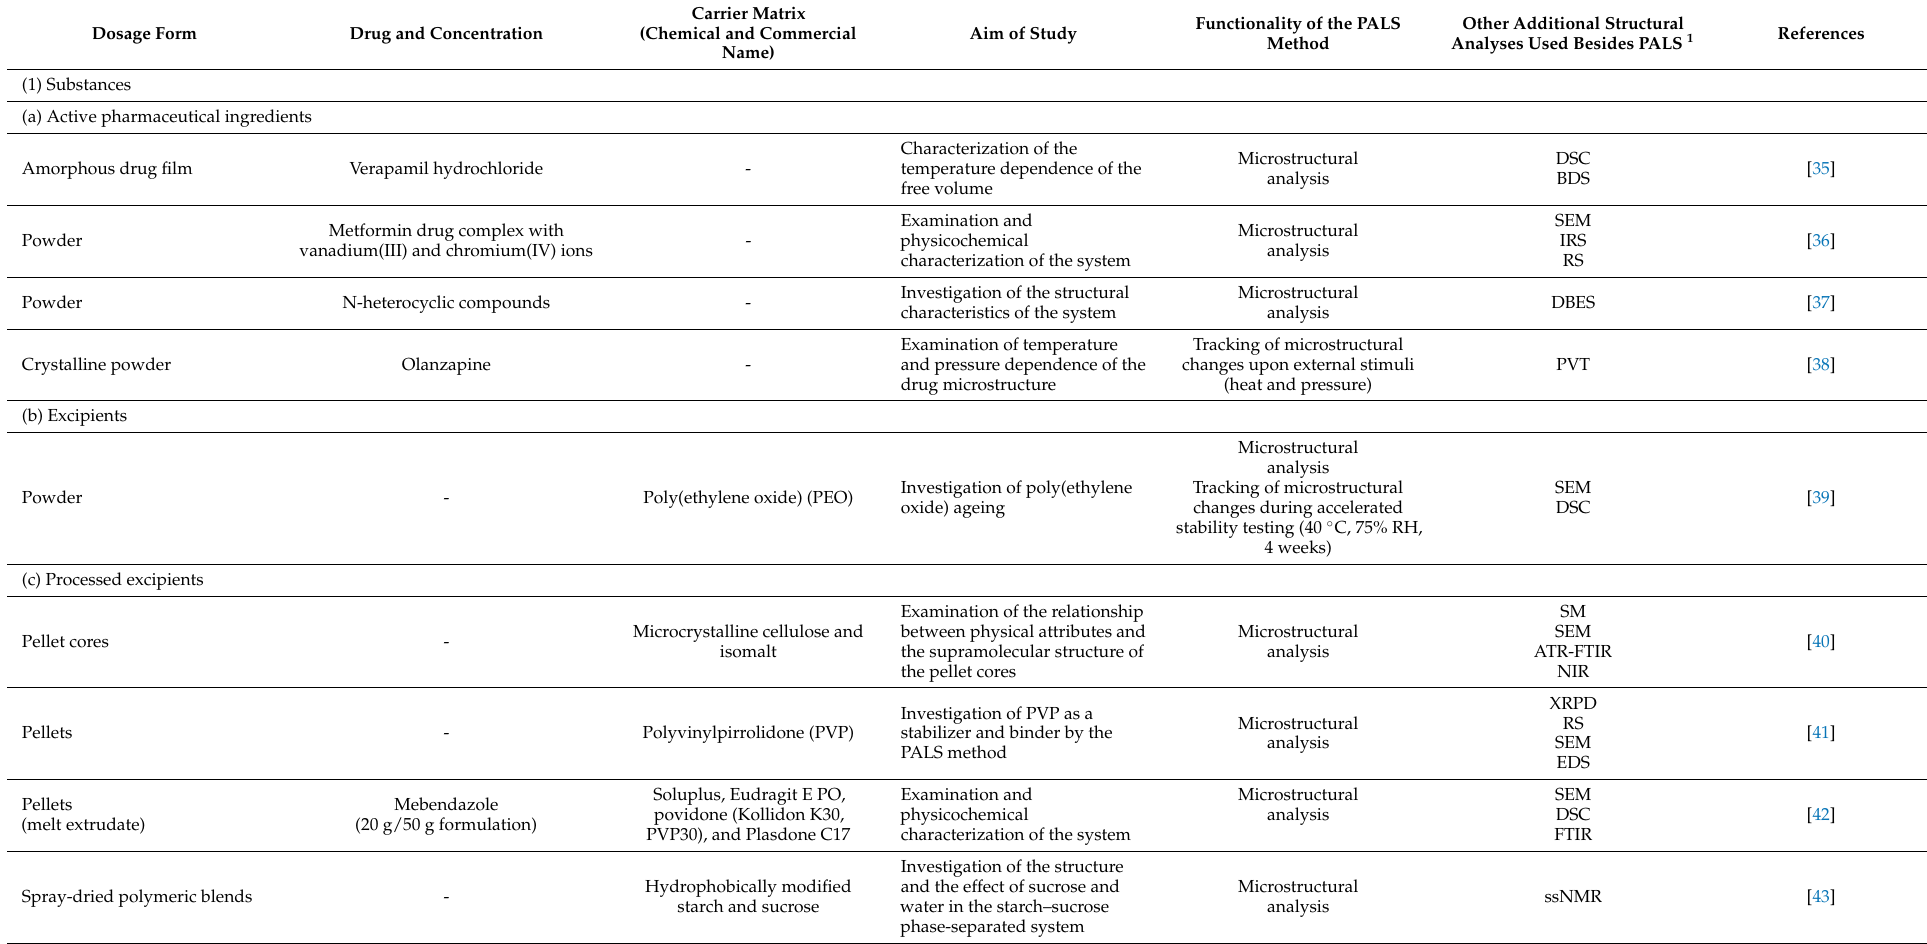
Table 2. Summary of scientific publications related to the PALS